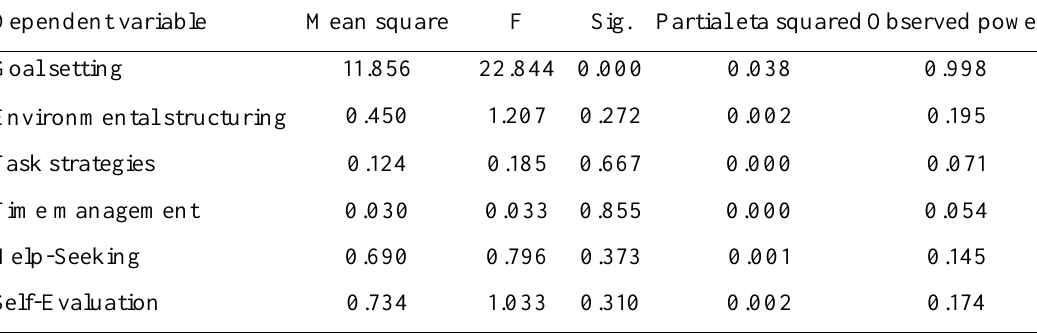
Results of Tests of Between-Subjects Effects Dependent